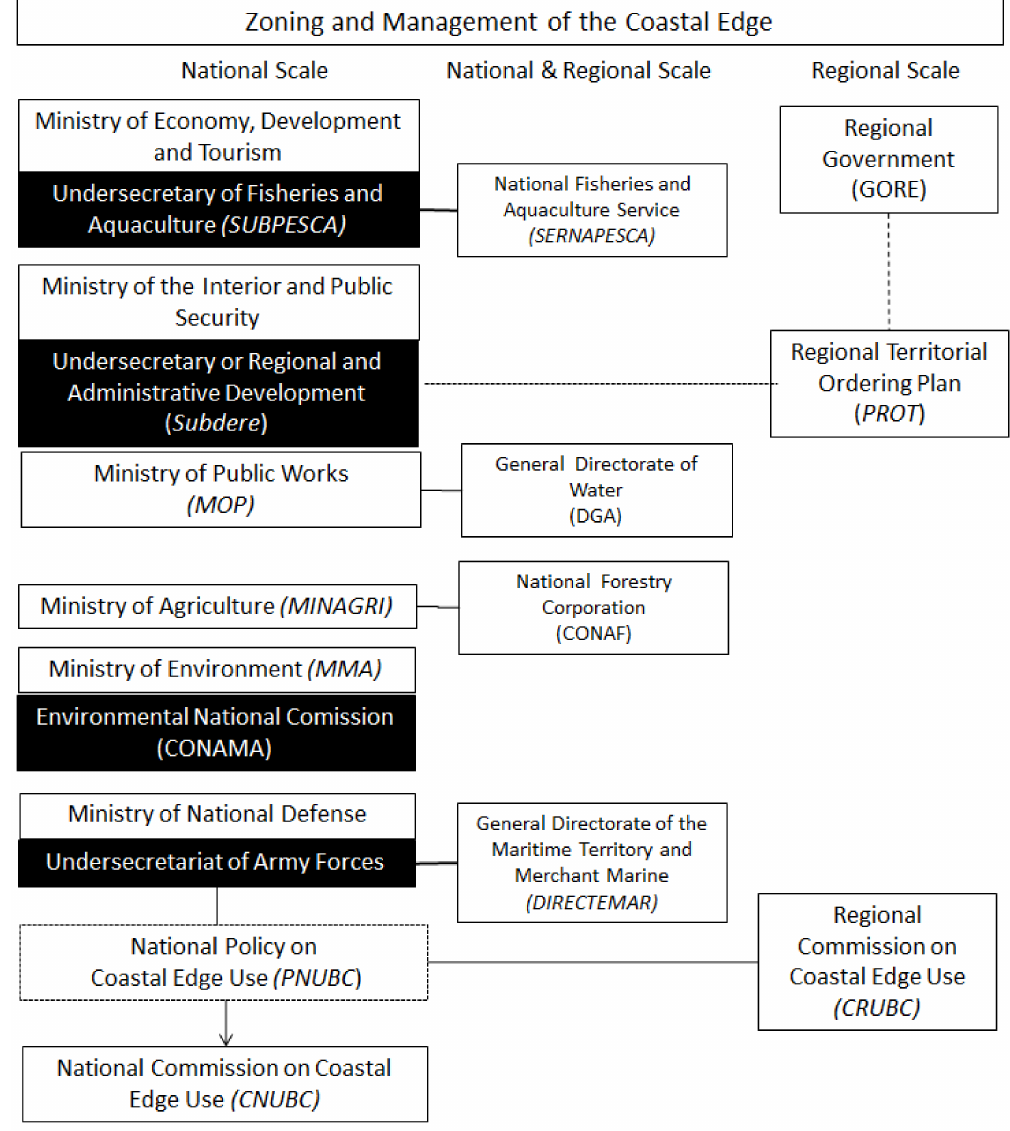
Figure 1. Institutions involved and areas of action in the coastal zone